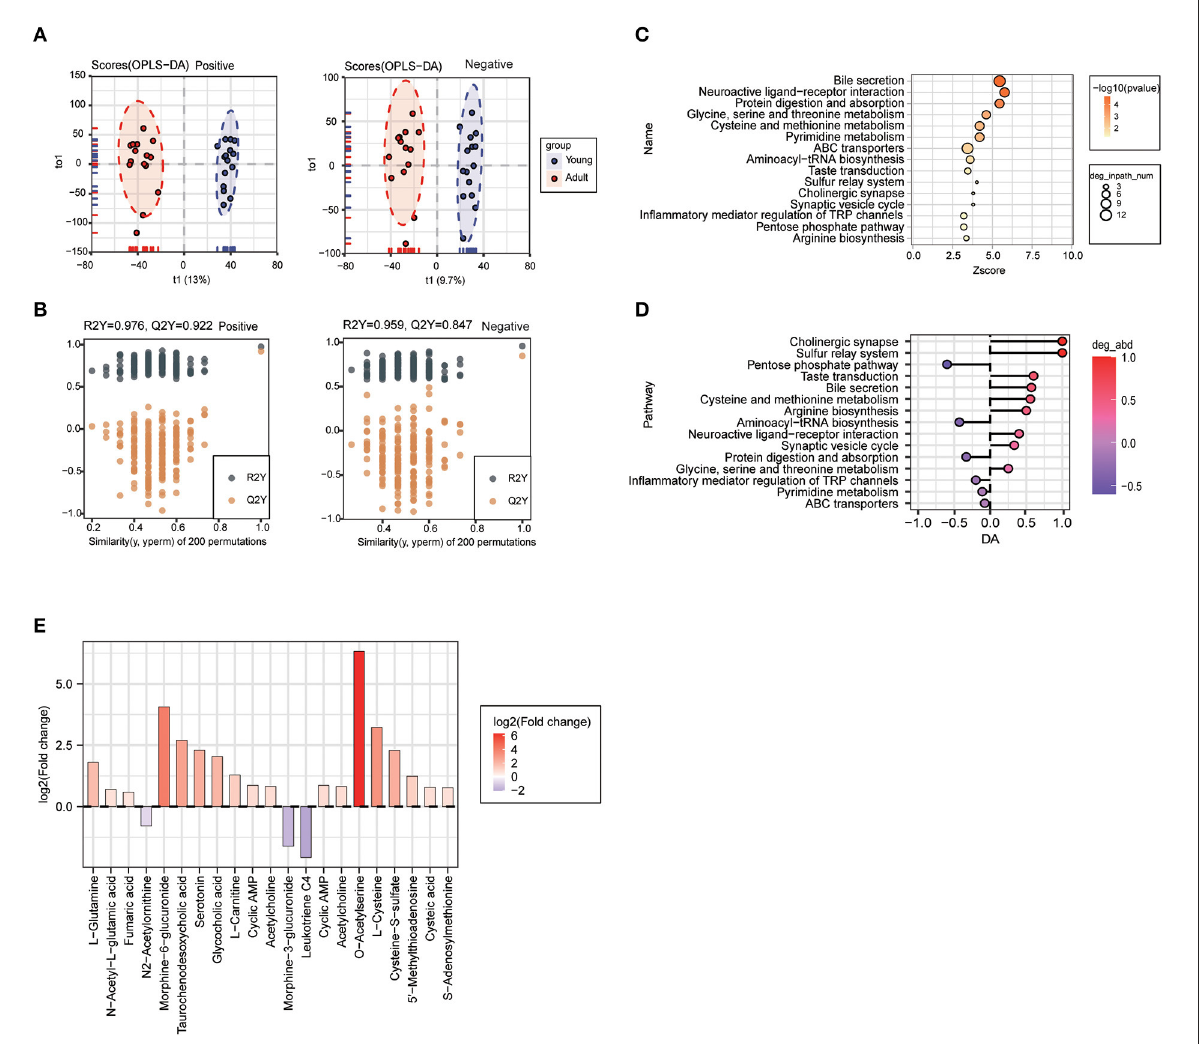
FIGURE6 Urine metabolite profile undergone significantly change during body growth. OPLS-DA score plot (A) and OPLS-DA validation plots (B) urine samples from the young group and adult group. (C) KEGG pathway enrichment analysis of differential metabolites in comparison between the two groups, and the top 15 significantly enriched pathways are listed. (D) Differential abundance analysis of top 15 KEGG pathways. (E) Analysis of the urine differential metabolites in adult dogs compared with young dogs. Red represents increased and purple represented decreased abundance in adult